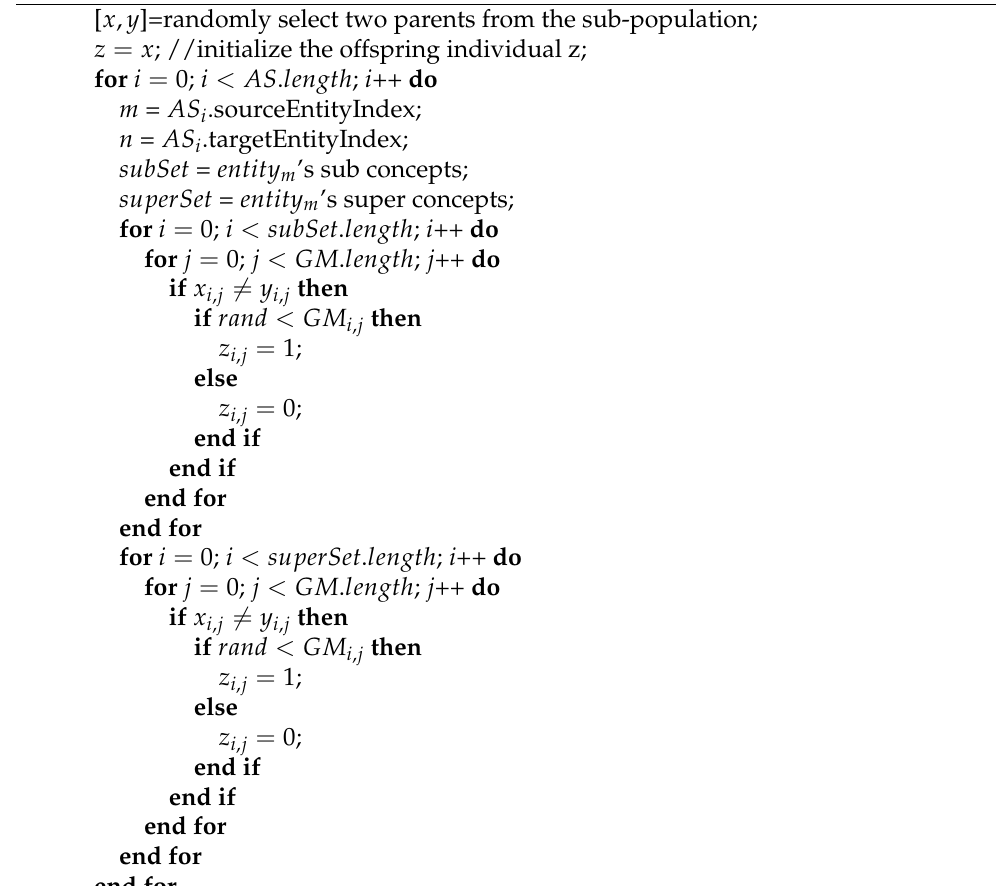
Algorithm 3: Crossover